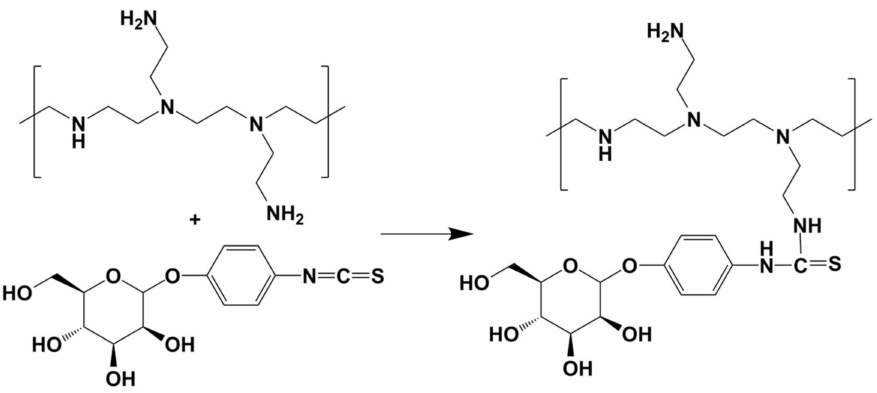
Figure 2. Reaction scheme for the synthesis of Man-PEI. PEI1800 reacted with α -D- Mannopyranosylphenyl isothiocyanate for 24 h to produce Mannosylated PEI. The product was purified through